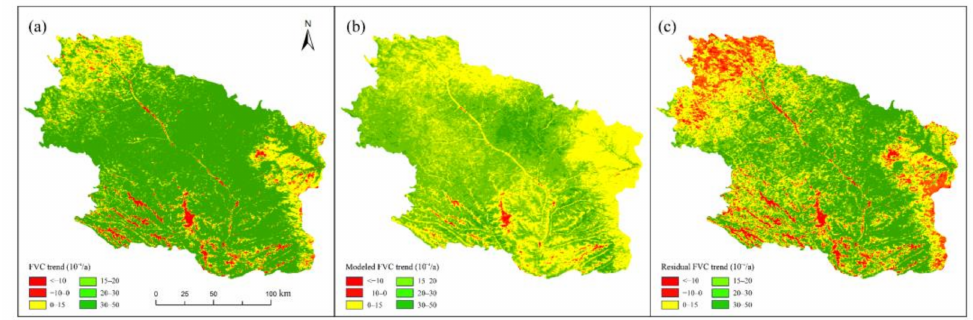
Figure 10. Trend variation of FVC in Qingyang from 2000 to 2019. ( a ) FVC trend; ( b ) dominated by climate variables; ( c ) dominated by human factors.